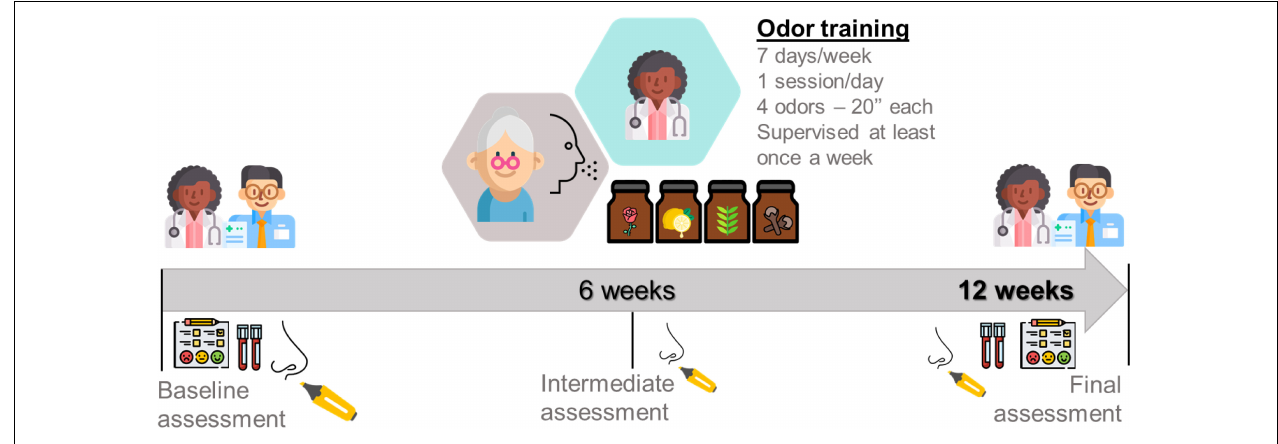
FIGURE 2 | Odor training protocol (own